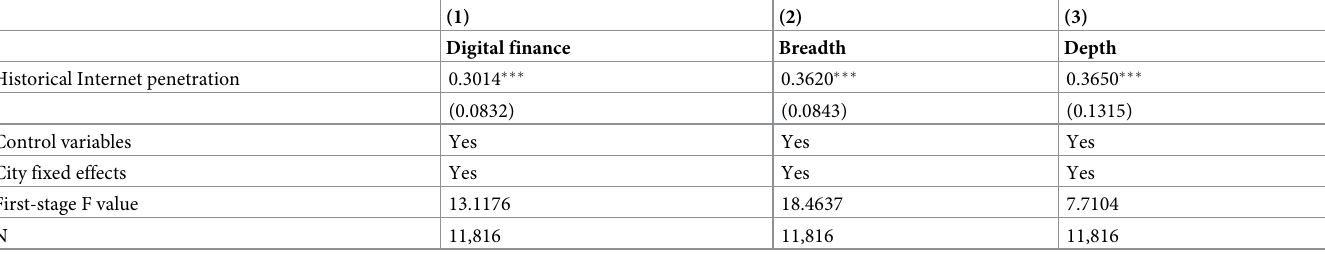
Table 16. The impact of digital finance on rural household poverty: IV methods (first-stage results).